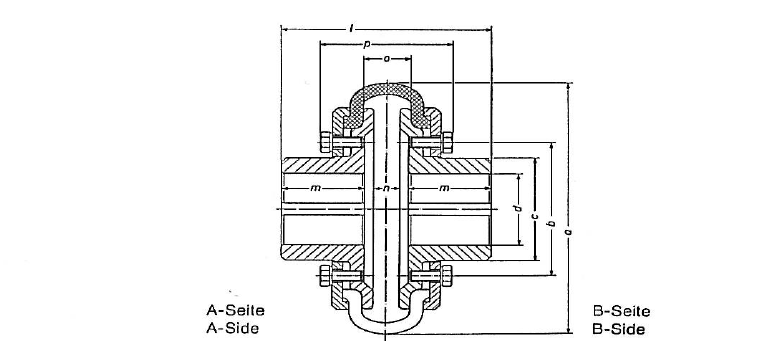
Figure 18 – Flexible coupling of Stromag Periflex Version PNA type, size 225 R and 426 R Рисунок 18 – Эластичные муфты Stromag Periflex тип PNA, размер 225 R и 426 R Слика 18 – Еластичне спојнице Stromag типа Periflex, изведбе PNA, величине 225 R и 426